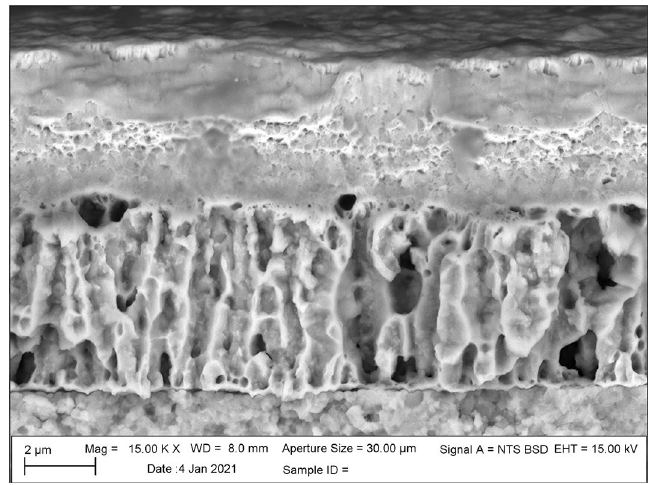
Figure 2. SEM micrograph of a 3 µm thick Pd film deposited onto a 5 µm thick Cu film (as-deposited condition).